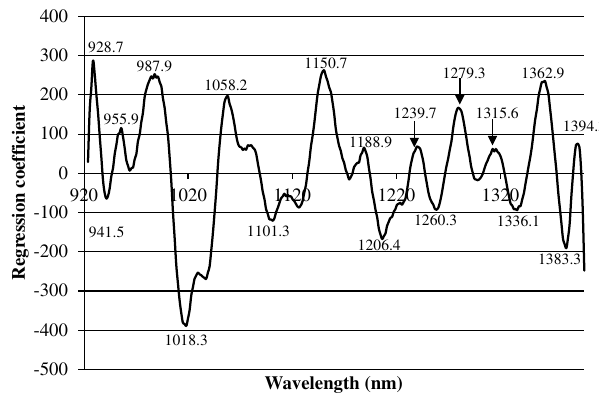
Fig. 5. Regression coe±cient plot with respect to wavelength of model predicting mung bean seed orientation.